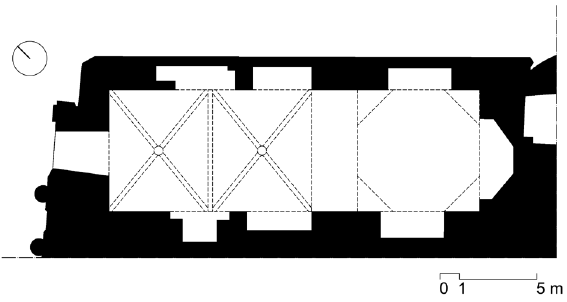
Figure 3 . Plan of the Chapel of San Miguel.